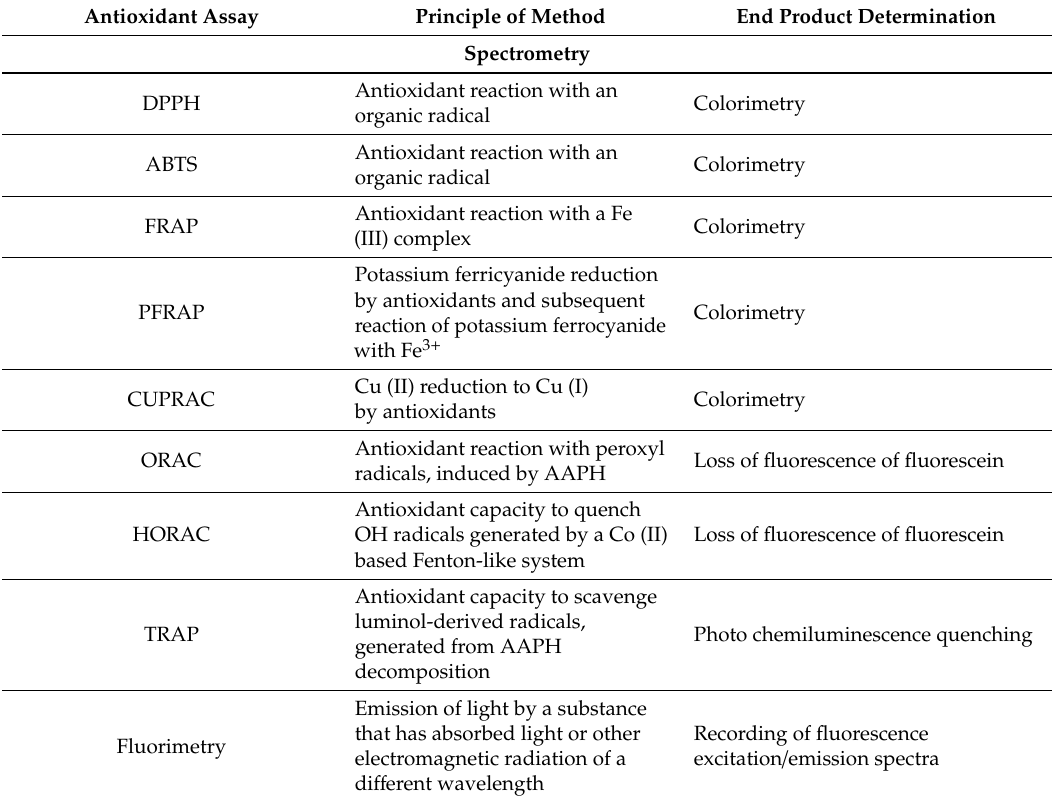
Table 1. Di ff erent techniques used to measure antioxidant activity (Source: